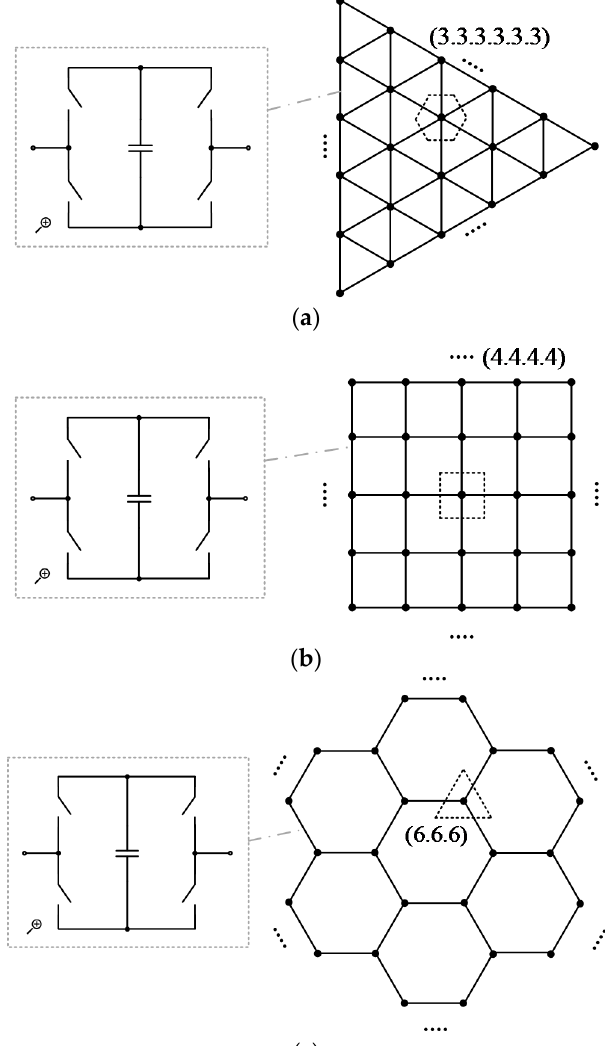
Figure 2. Three existing lattice converters based on regular tilings: ( a ) (3.3.3.3.3.3); ( b ) (4.4.4.4); ( c ) (6.6.6).